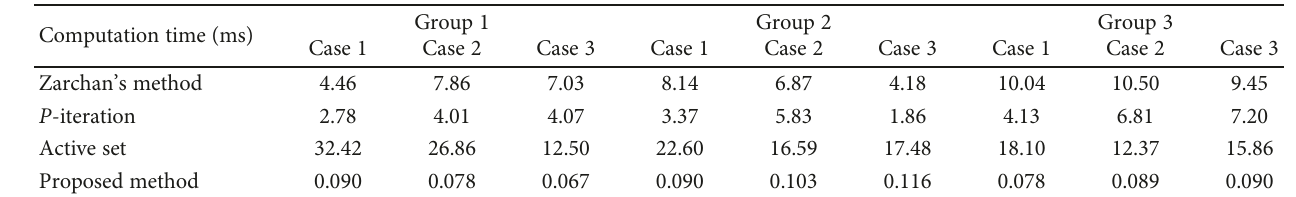
Table 4: Comparisons of the computation time.